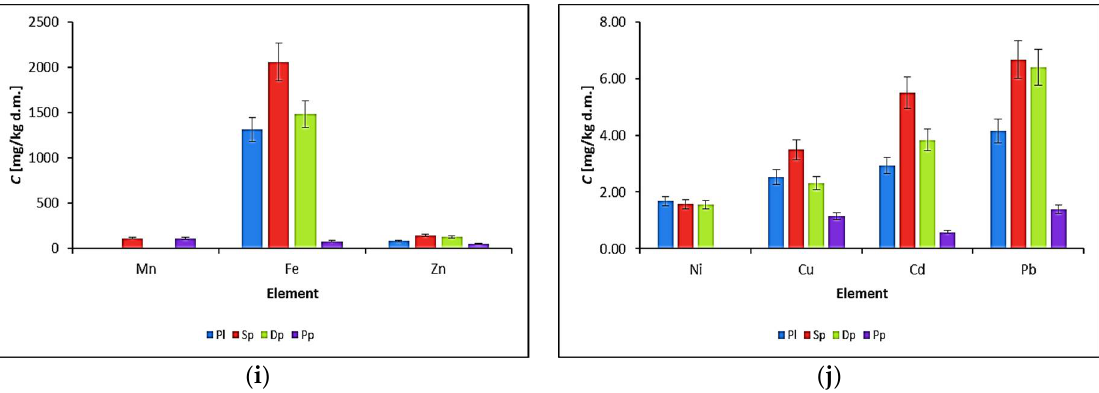
Figure 3. Changes in concentrations of heavy metals determined in mosses and algae exposed in the Mała Panew River; at point 1: ( a , b ); at point 2: ( c , d ); at point 3: ( e , f ); at point 4: ( g , h ); at point 5: ( i , j ).